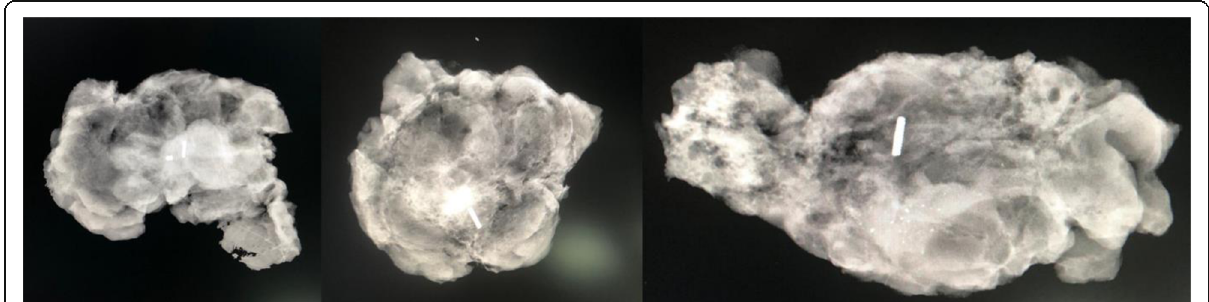
Fig. 1 Examples of specimen radiographs showing the identification target in the centre of the